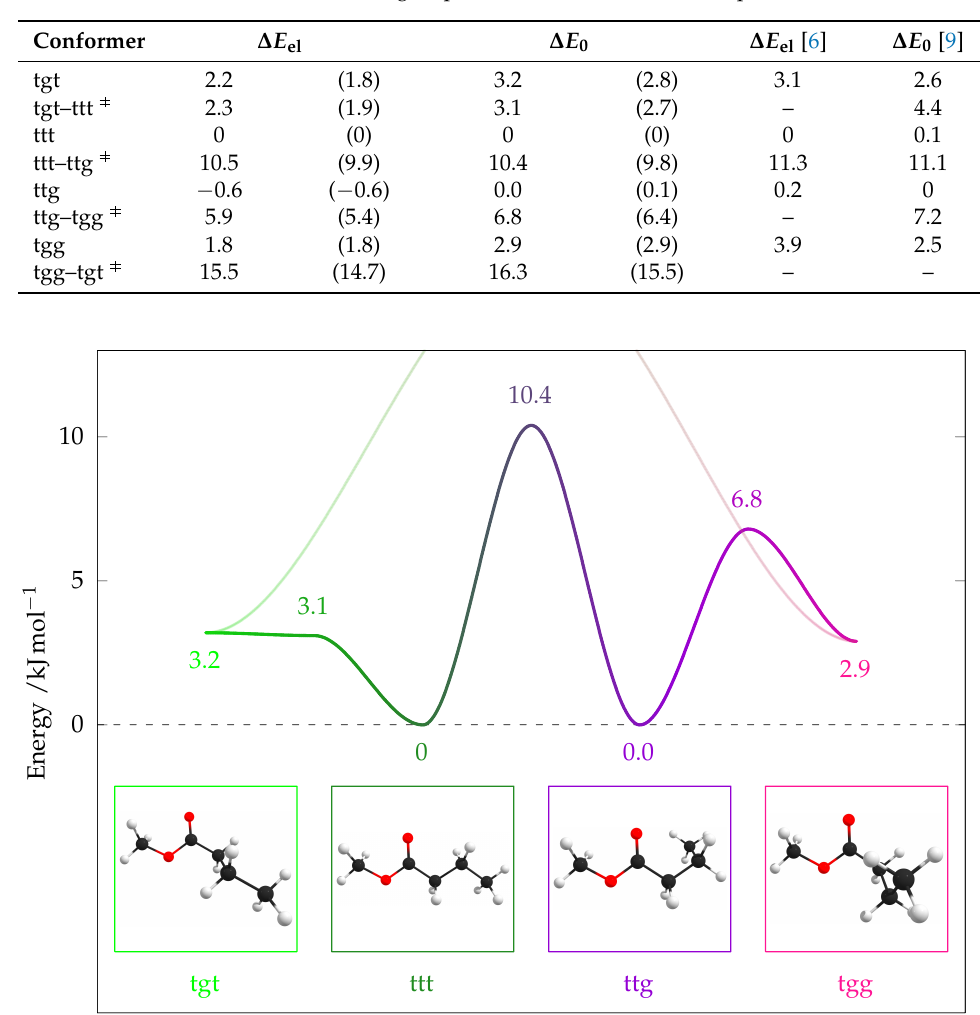
Figure 9. Relative energies and barriers of interconversion of the main conformers of methyl butanoate on CCSD(F12*)(T*)//B3LYP level (ZPE included). Isomerisation about the C α C β bond is more feasible if the OCC α C β dihedral is in t orientation (the barrier for g orientation exceeds the displayed energy range).